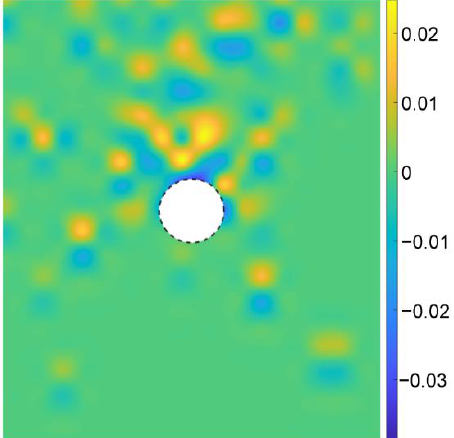
Figure 15. Variation in the void ratio after the tunnel excavation in the basic case of AR2C3. The negative value indicates the excavation-induced reduction of void ratio.